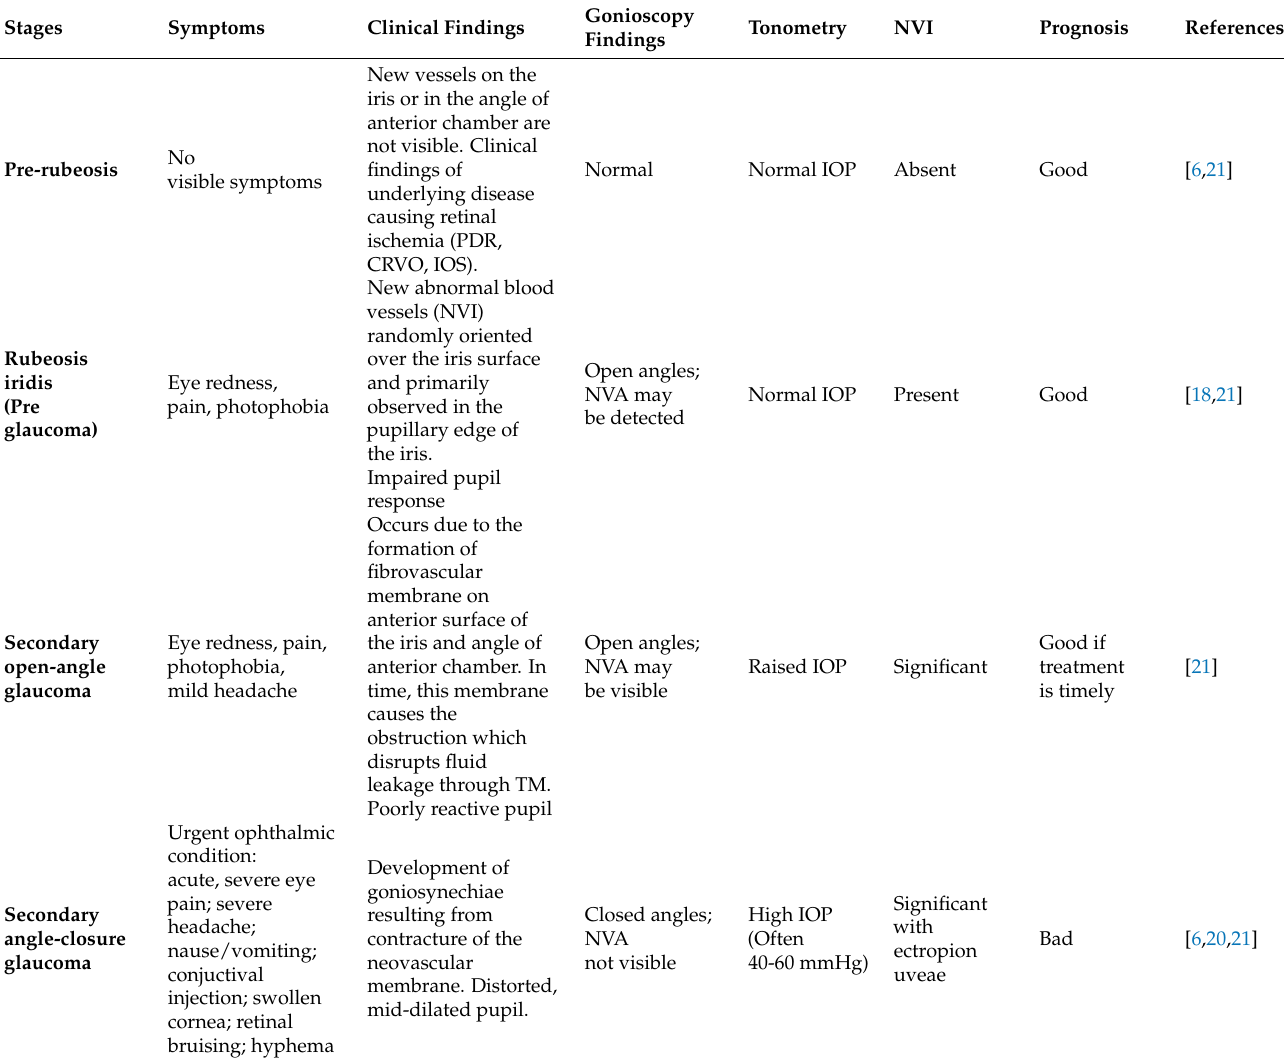
Table 2. Clinical stages of